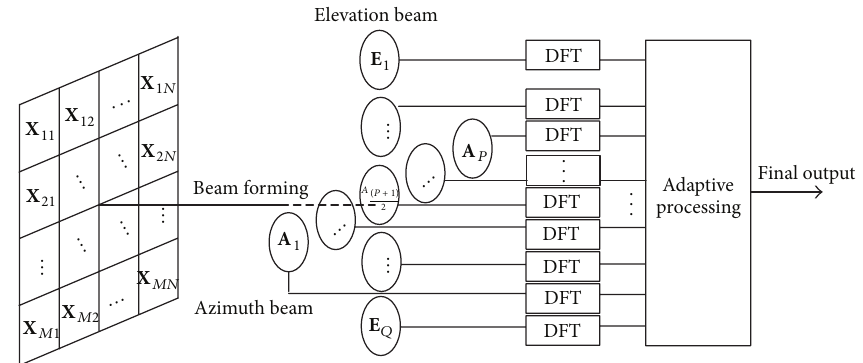
Figure 4: Schematic of the cross beam STAP method.